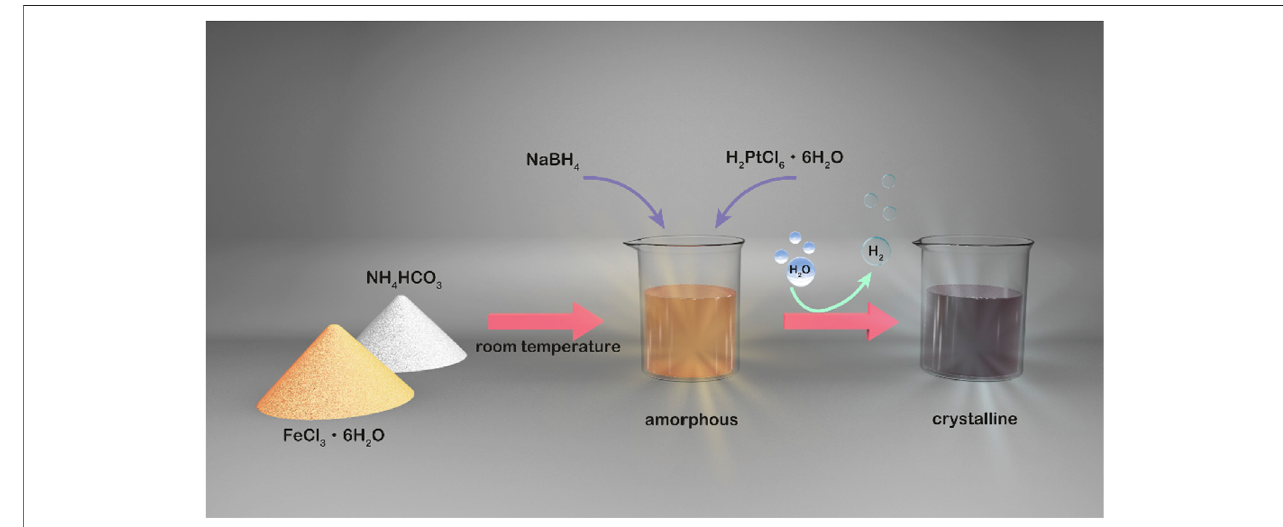
FIGURE 2 | Synthesis mechanism of Pt/FeOOH QD.